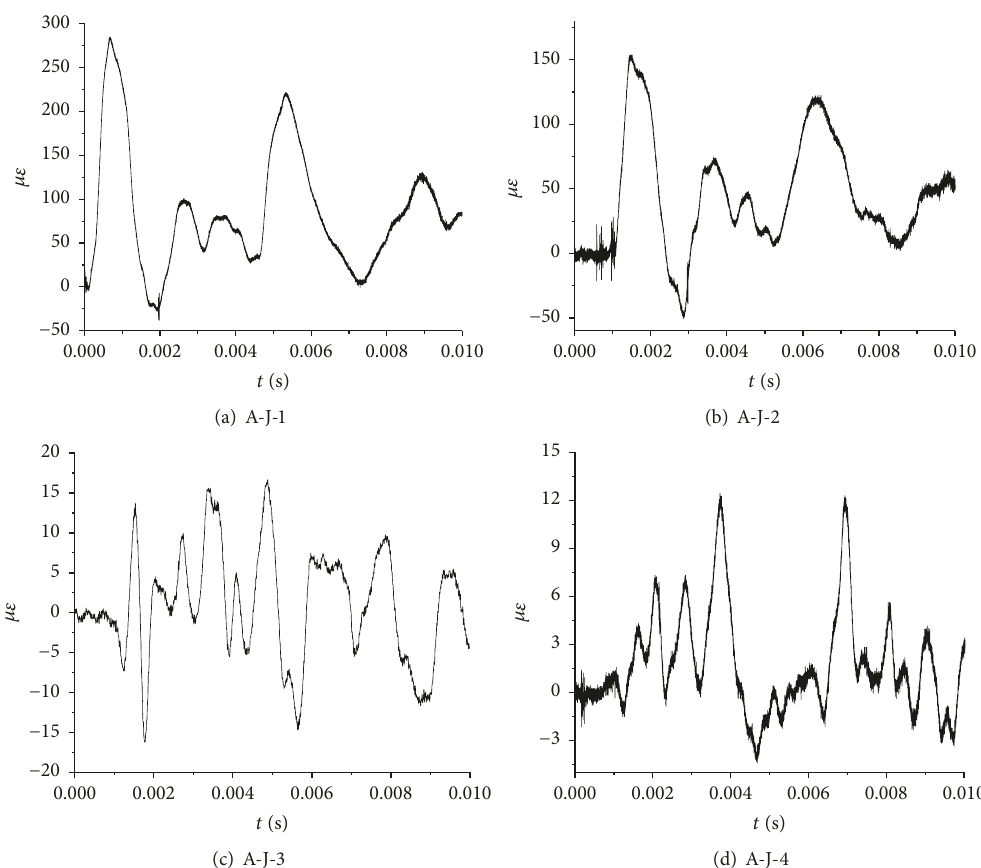
Figure 18: Model 1’s axial strain wave with an explosive charge of 0.8 kg.